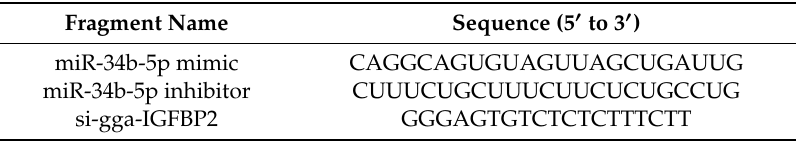
Table 1. Oligonucleotide sequences used in this